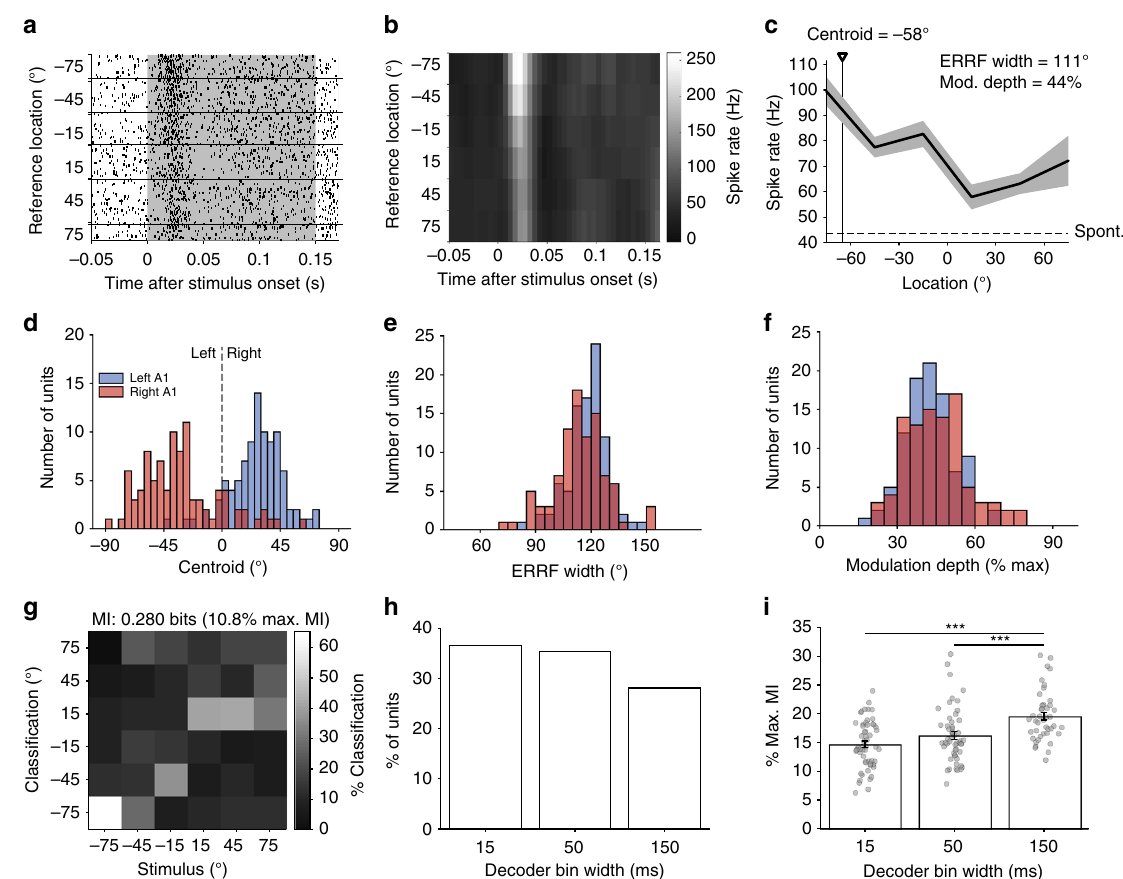
Fig. 3 Spatial tuning properties in response to broadband noise. a Example, raster plot from one unit, with trials ordered by the location of the reference sound. The duration of stimulus presentation is indicated by the grey box. b Post-stimulus time histogram (spikes binned at 5 ms resolution). c Spatial receptive fi eld (mean ± standard error of the mean (s.e.m.)) spike rate calculated over 150 ms at each location. The unit shows clear contralateral tuning and a centroid of − 58° (black triangle/line). The equivalent rectangular receptive fi eld (ERRF) width and modulation depth are also indicated in the fi gure. The dotted line represents the spontaneous fi ring rate. d Distribution of centroids, ERRF widths ( e ) and modulation depths ( f ) for all spatially modulated units ( N = 190) split by left (blue, N = 95) and right (red, N = 95) auditory corttices (AC). g Stimulus location decoded with a Euclidean distance decoder on the spike response binned with 15 -ms resolution for the unit in a – c . The mutual information (MI) and percentage of maximum MI are indicated. h Distribution of best decoder bin widths for signi fi cantly informative units ( N = 153). i Mean percentage of maximum MI ± s.e.m. of signi fi cant units from ( h ). Raw data are shown in grey circles. ( N = 56, 54, 43). Statistics: one-way ANOVA with Tukey – Kramer post-hoc pairwise comparisons. *** p < 0.001